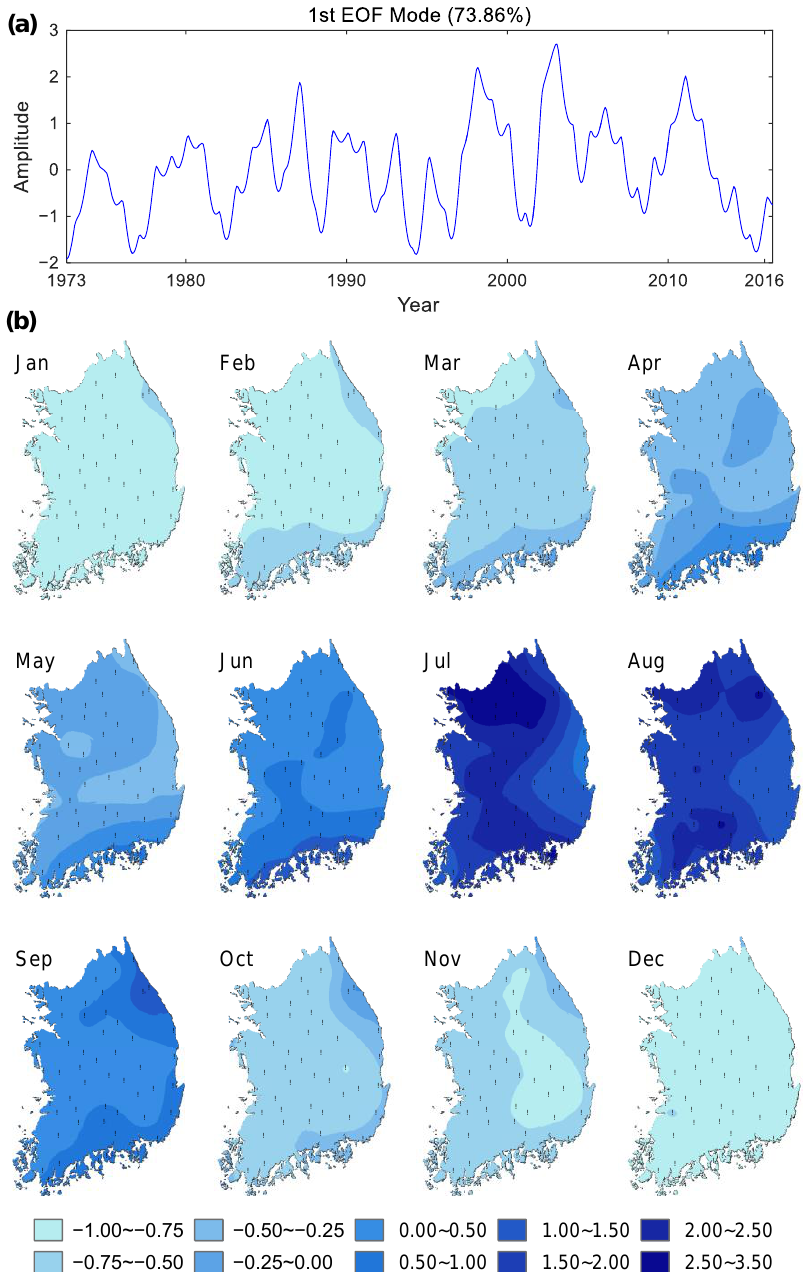
Figure 7. First CSEOF modes of precipitation: ( a ) principal component time series, ( b ) cyclostationary loading vectors (CSLV).